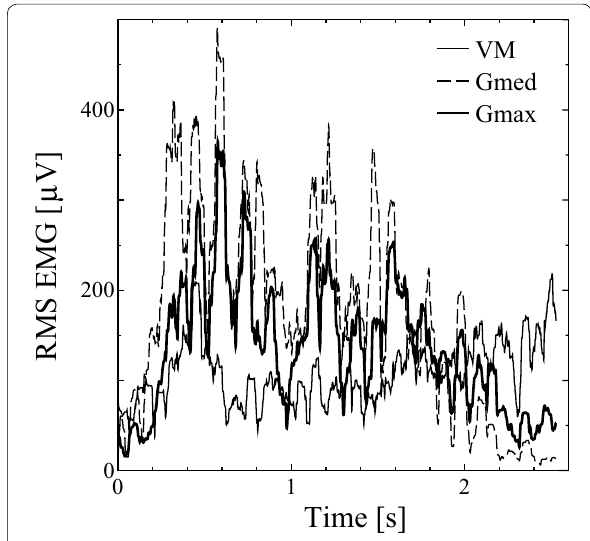
Fig. 21 RMS EMG during isokinetic exercise. The target speed was 0.25